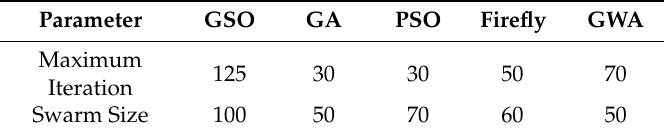
Table 6. Iteration and swarm size used in the optimization algorithm.